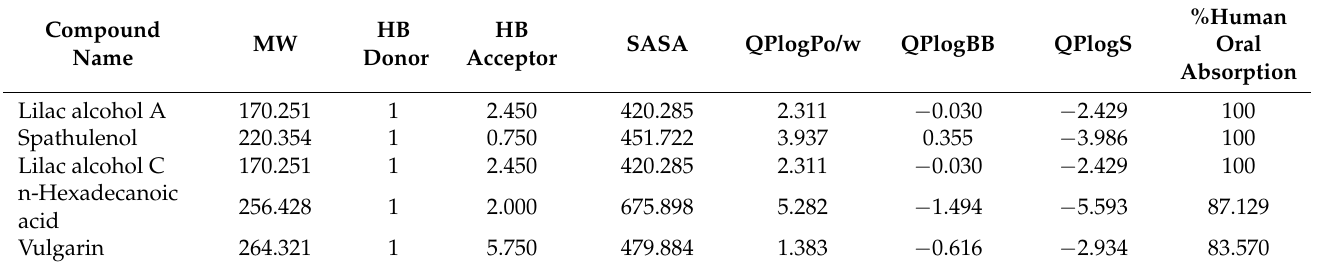
Table 2. Principle descriptors calculated for the selected ligands of A. pallens